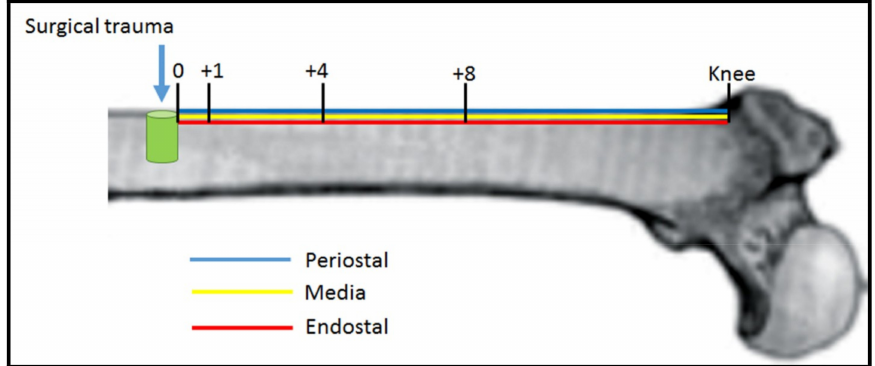
Figure 3. Schematic figure showing position and regions used for cell counting. Distances in mm from the performed bone lesion (Zero, +1, +4, 8 and knee) are shown. Each position was assayed in three different regions: periostal (blue), media (yellow), and endostal (red). Bone microdamage generated by the compression of the implants during their installation (bone microcrack) was analyzed in G2 samples by optic